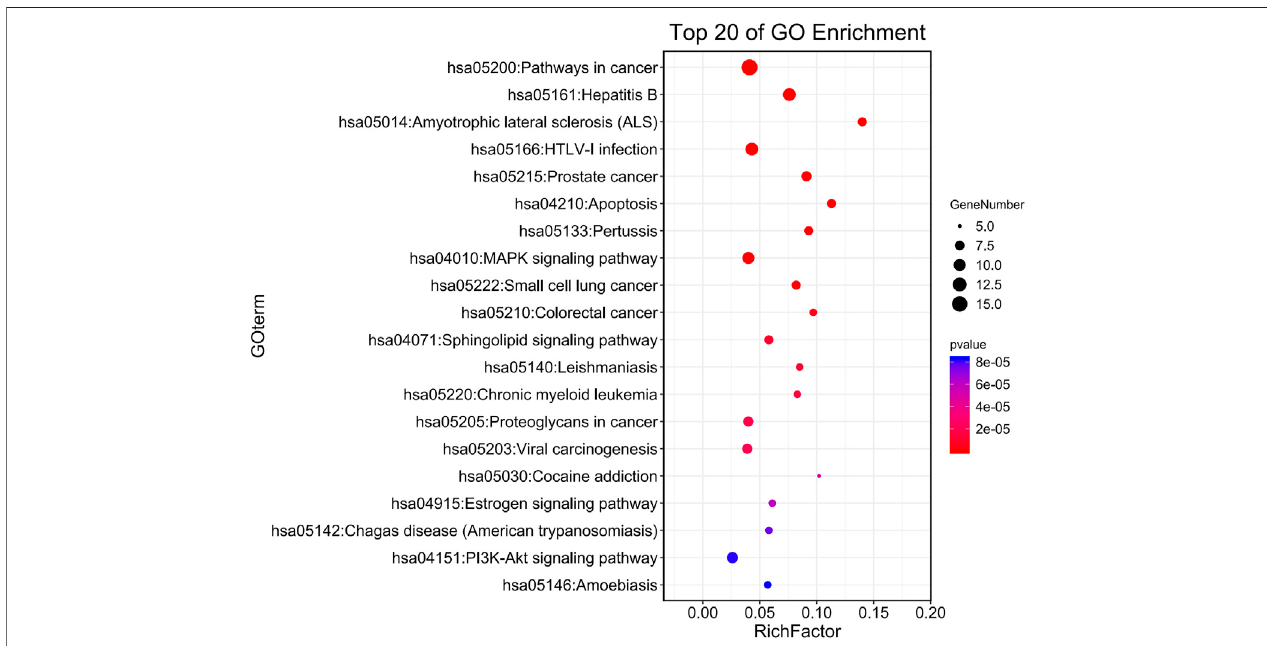
FIGURE4| KEGGpathwayanalysis.ThelargerRichFactoris,thegreaterthedegreeofenrichmentis;Therangeof p valueis[0,1],andthecloseritisto0,themore signi fi cant the enrichment is.